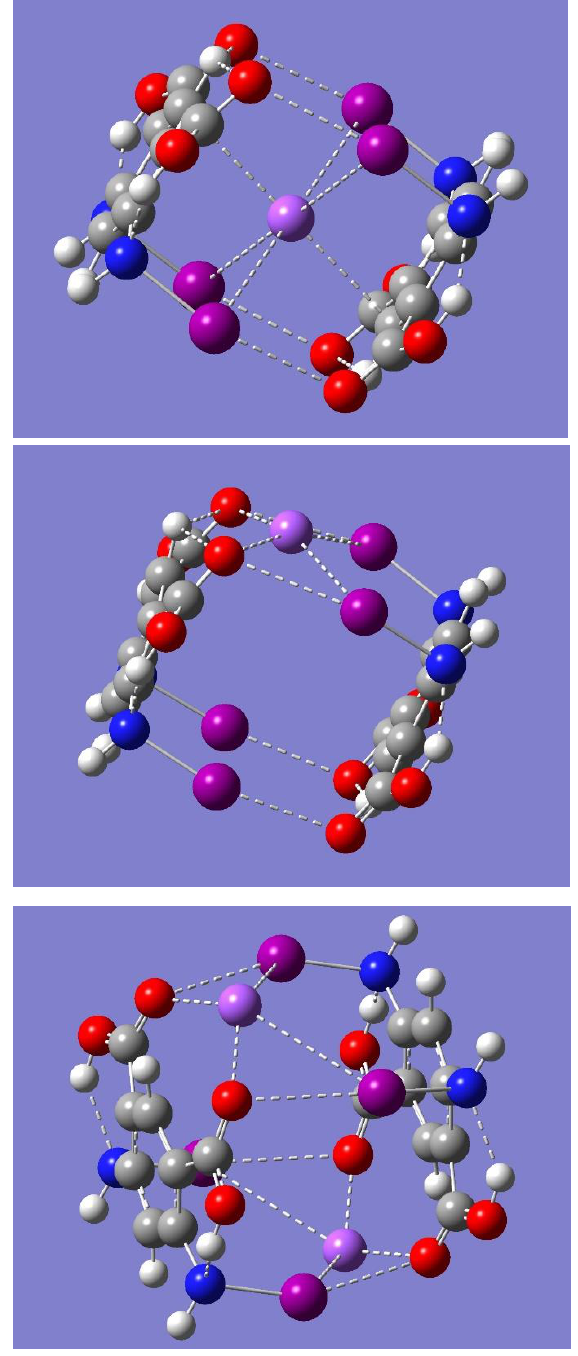
Figure 6. Optimized geometry of the Dimer-Na + complex of C 2h symmetry ( top ), the Dimer-Na + complex of C s symmetry ( middle ), and the Dimer-2Na + complex of C 2h symmetry ( bottom ). Intramolecular OH…N hydrogen bonding interactions, and intermolecular HC…Na + and NI…O=C interactions indicated with respective dashed lines. Individual atoms can be distinguished by color: C (grey), H (white), N (blue), O (red), and I (purple).